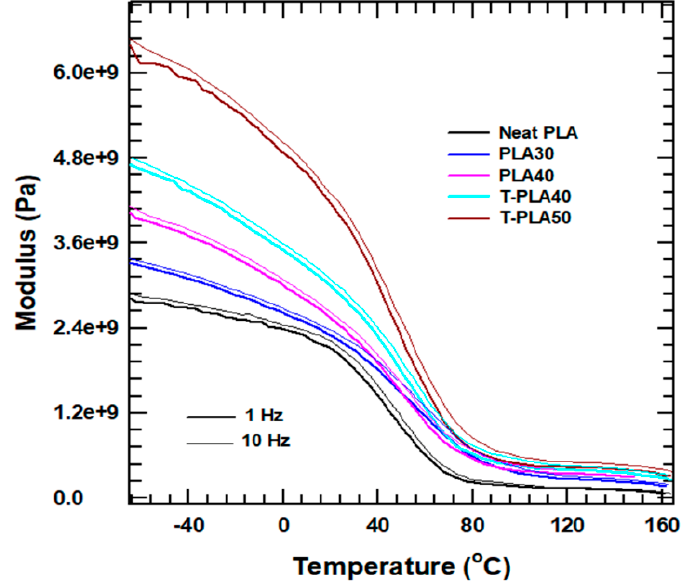
Figure 7. Storage modulus as a function of temperature at different frequencies.